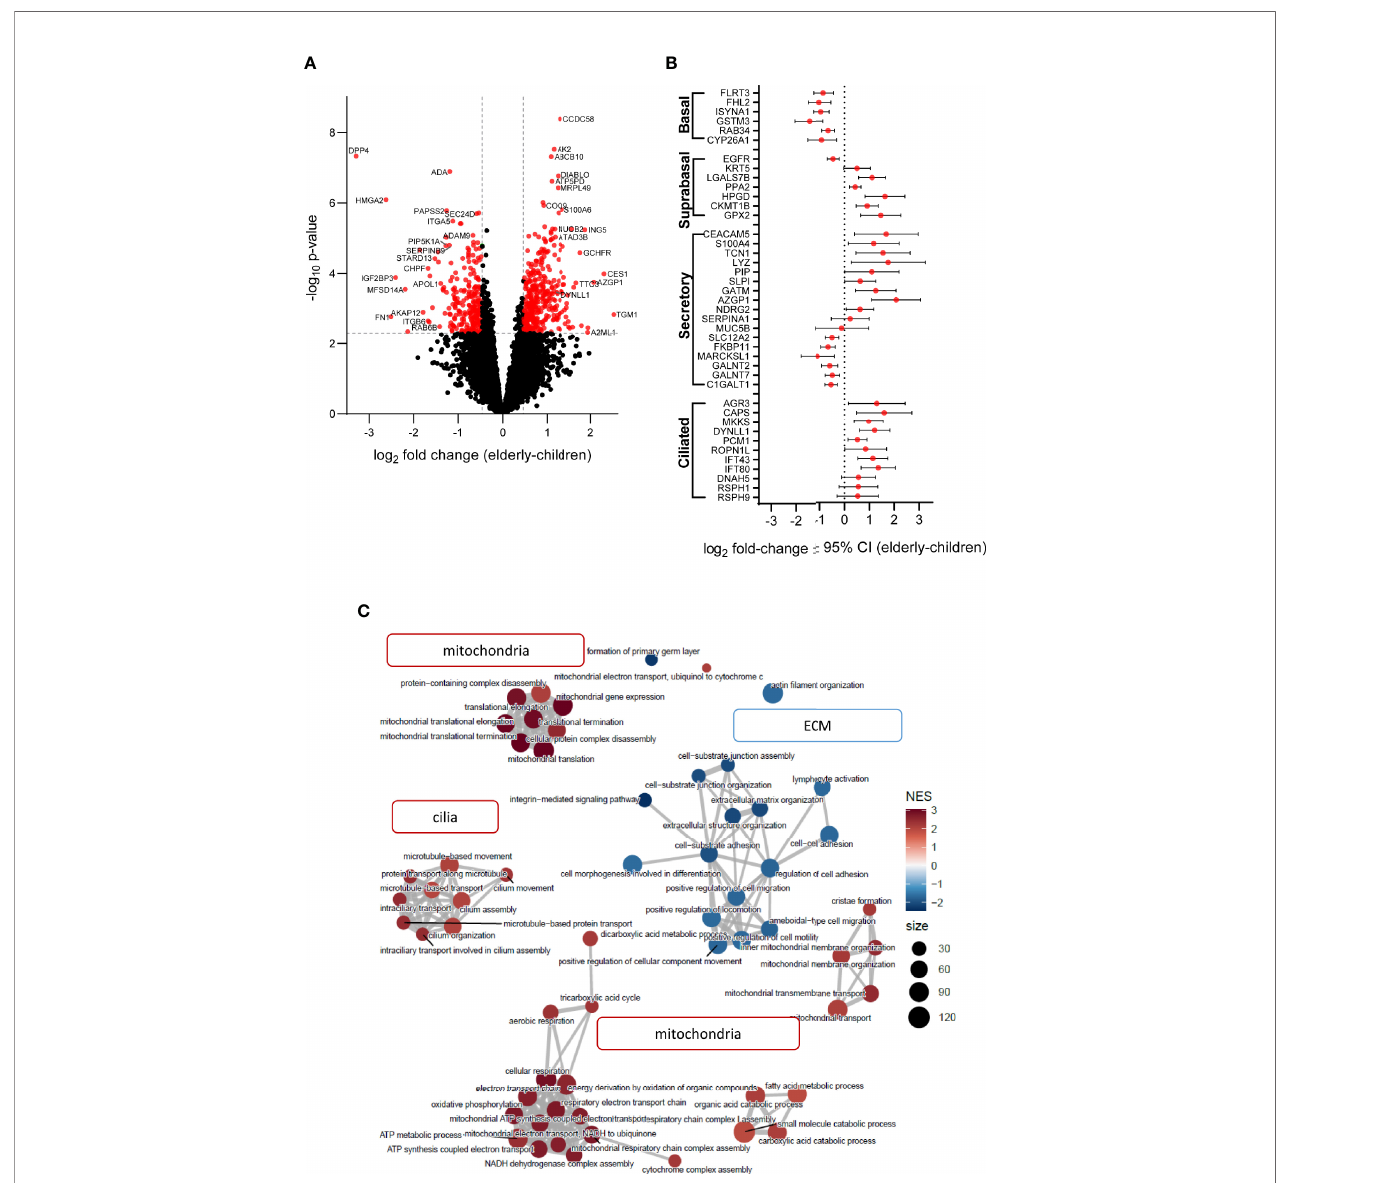
FIGURE 4 | Age-related differences in proteome signatures of nasal epithelial cultures from healthy children compared to elderly people. (A) Differential protein expression between age groups with reference to children (volcano plot) illustrates fold-change expression (log 2 scaling) and signi fi cance ( – log 10 scaling, adjusted p - value). Signi fi cantly differently abundant proteins are colored red (adjusted p -value < 0.05 and fold-change > 1.38). (B) Protein expression of airway cell subtype markers. The log 2 fold-change with 95% con fi dence interval (CI) of detected proteins for each marker is plotted on the x -axis. (C) Enrichment map of top 60 gene ontology/biological process terms yielded by GSEA. Each node corresponds to a gene set with either high (red) or low (blue) normalized enrichment score (NES) in the elderly group. Node size correlates with number of genes that are annotated to the